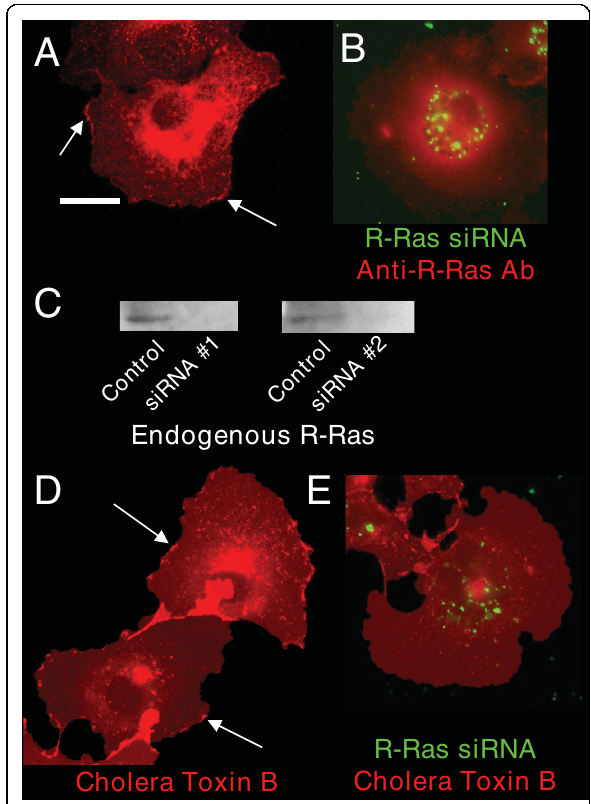
Figure 1 Endogenous R-Ras and b 1 -integrin localize to membrane ruffles . (A) The localization of endogenous R-Ras in Cos7 cells was determined by immunocytochemistry using antibody specific for R-Ras, which assembled into ruffles (arrows). (B) Immunofluorescence of a cell containing fluorescently labeled siRNA directed against R-Ras shows a loss of R-Ras from the plasma membrane, which occurred in 30/30 cells imaged. Perinuclear staining with this antibody in both A and B is non-specific, as determined by peptide competition experiments (not shown). (C) Western blot analysis to demonstrate R-Ras knock-down by transfection of either of two siRNA sequences targeting R-Ras (20 nM). (D-E) Imaging of fluorescent cholera toxin B-stained cells shows localization to ruffles. This localization was lost in 13/15 cells upon knockdown of R-Ras with siRNA.